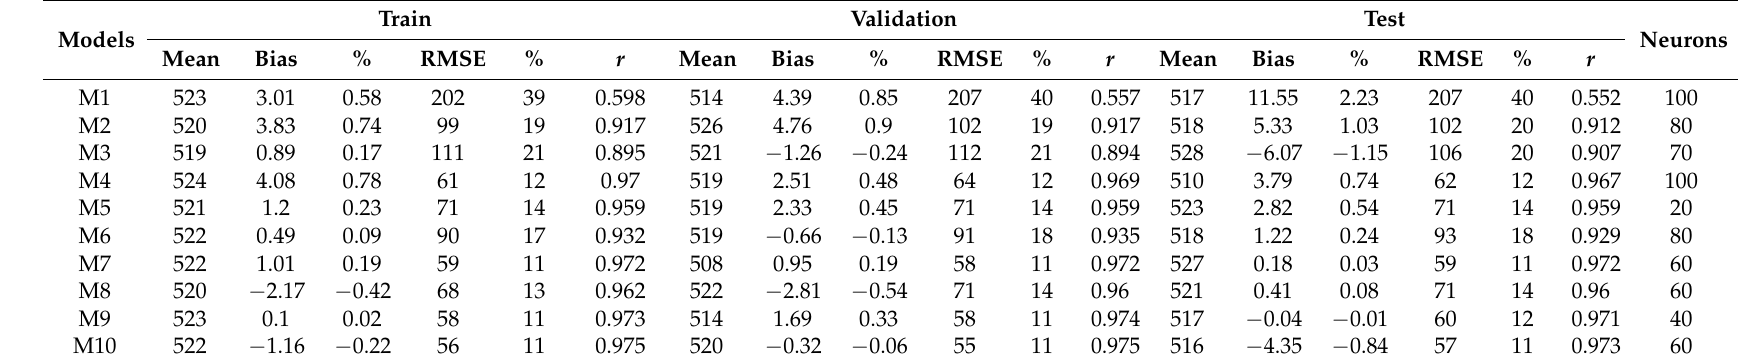
Table A5. As in Table A1, but for Tarjan tower station.